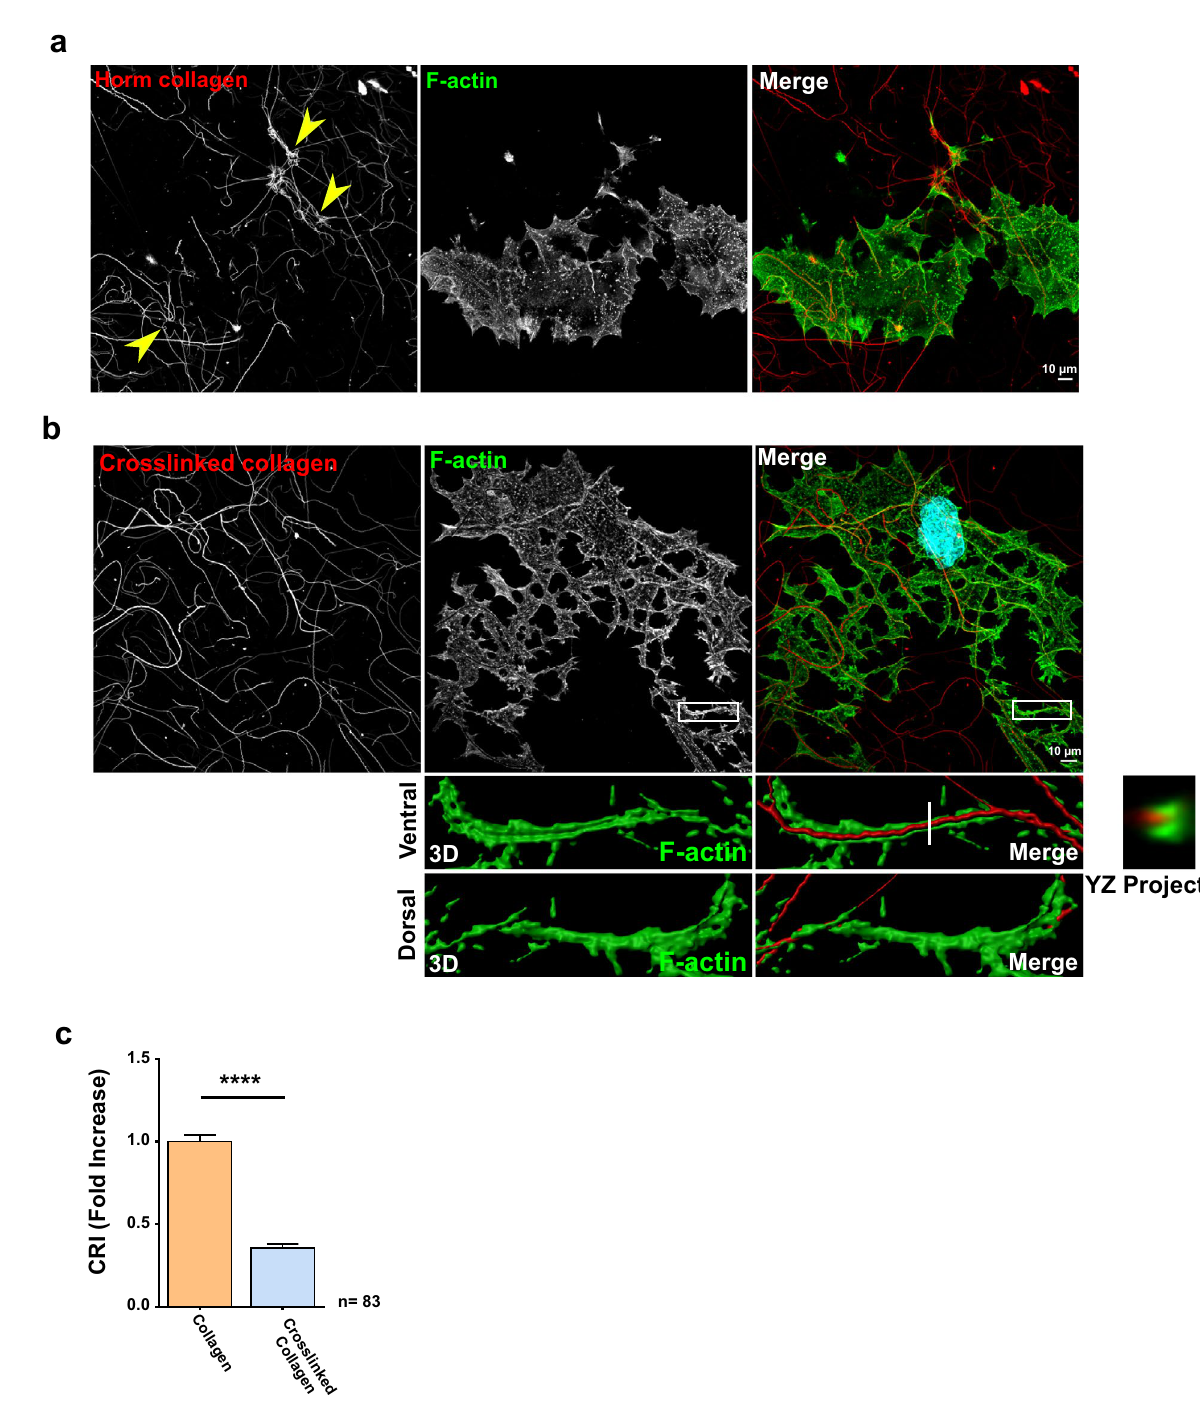
Figure 6. Immobilization of collagen fibers by crosslinking induces MKs to extent protrusions that follow the fibers network. ( a ) Representative image of D3MK cultivated for 24 h on labeled-Horm Collagen (100 µg/ml). Yellow arrows indicate tangled clumps of collagen. ( b ) Representative image of D3MK cultivated for 24 h on crosslinked labeled-Horm Collagen (100 µg/ml). Zooms show 3D surface rendering of a gutter linear podosome surrounding fibers. An orthogonal projection following the axis of the white line is shown (YZ projection). Scale bar = 10 µm. ( c ) Collagen remodeling index (fold increase) of collagen and glutaraldehyde crosslinked collagen. Values (mean ± S.E.M.) are from 4 independent experiments. ****P < 0.0001 according to by the Mann–Whitney test. n = number of cells